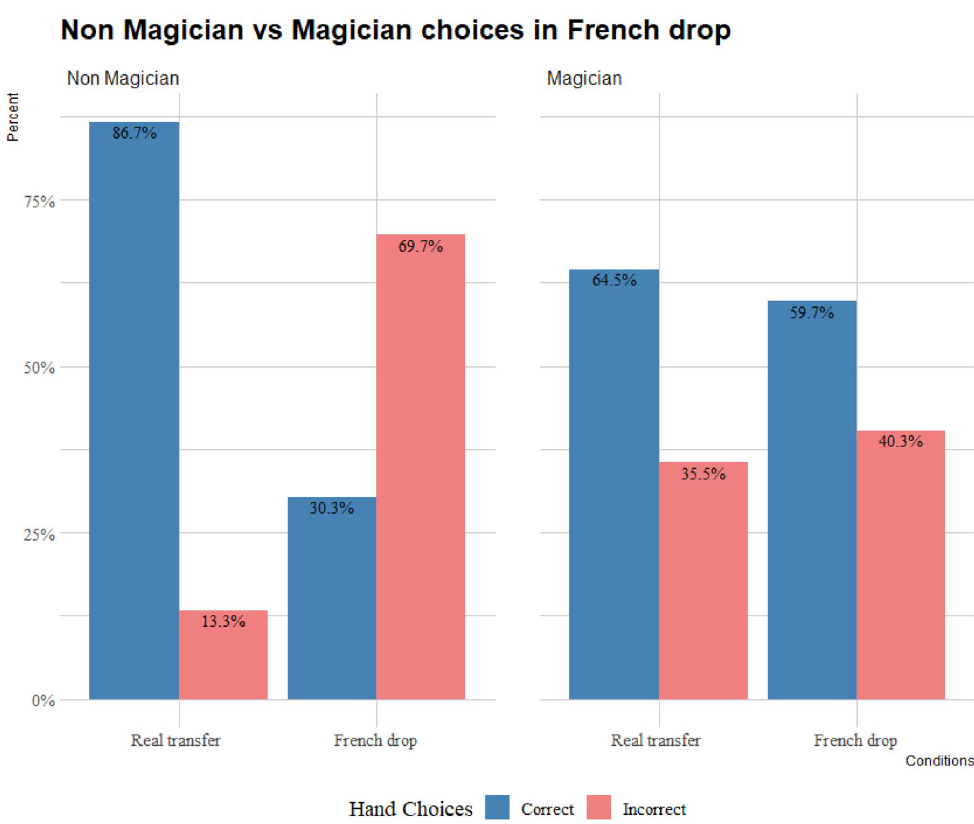
Figure 4. Choices of Non-magicians and magicians in French drop and real transfer